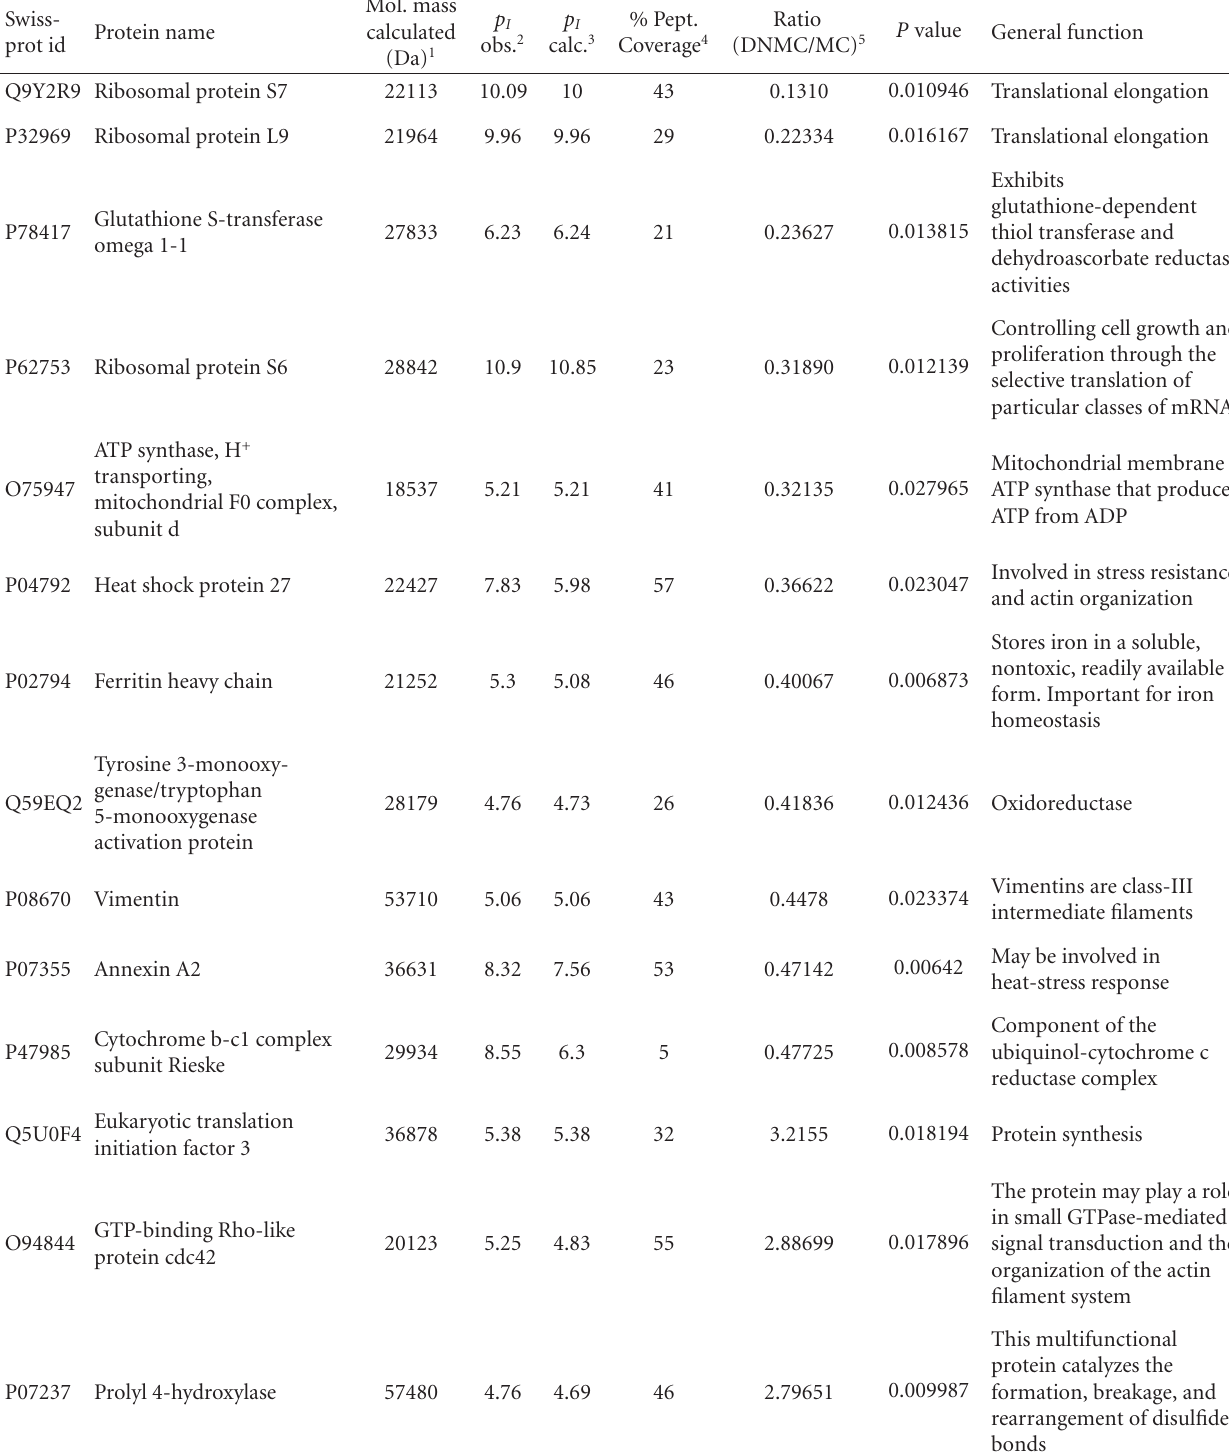
Table 3: Top 16 di ff erentially expressed proteins between melanocytes from dysplastic naevus and from normal skin.